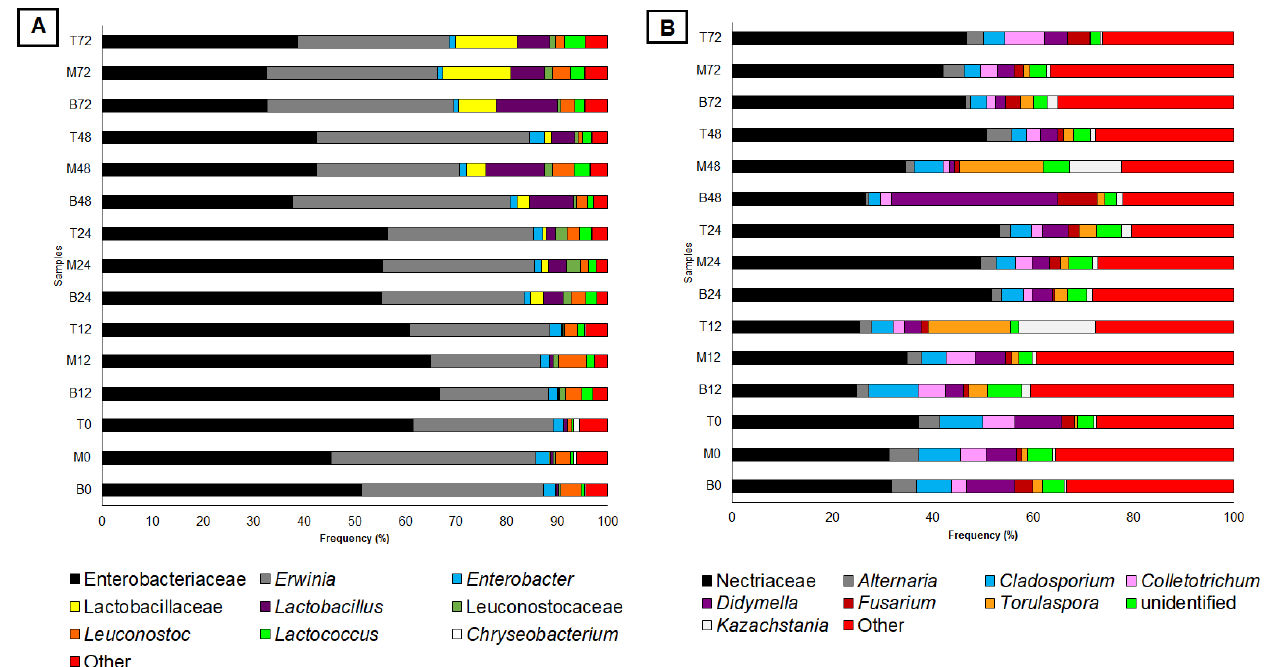
Figure 2. Composition of bacteria ( A ) and fungi ( B ) of samples collected in the bottom ( B ), middle (M), and top (T) layers of spontaneous coffee fermentation. Only bacteria and fungi with prevalence greater than 1% and 5% are shown, respectively. The number after each letter represents the fermentation time (e.g., B0 = bottom layer at 0 h). The complete list of minor microbial groups is reported in the Supporting Information (Table